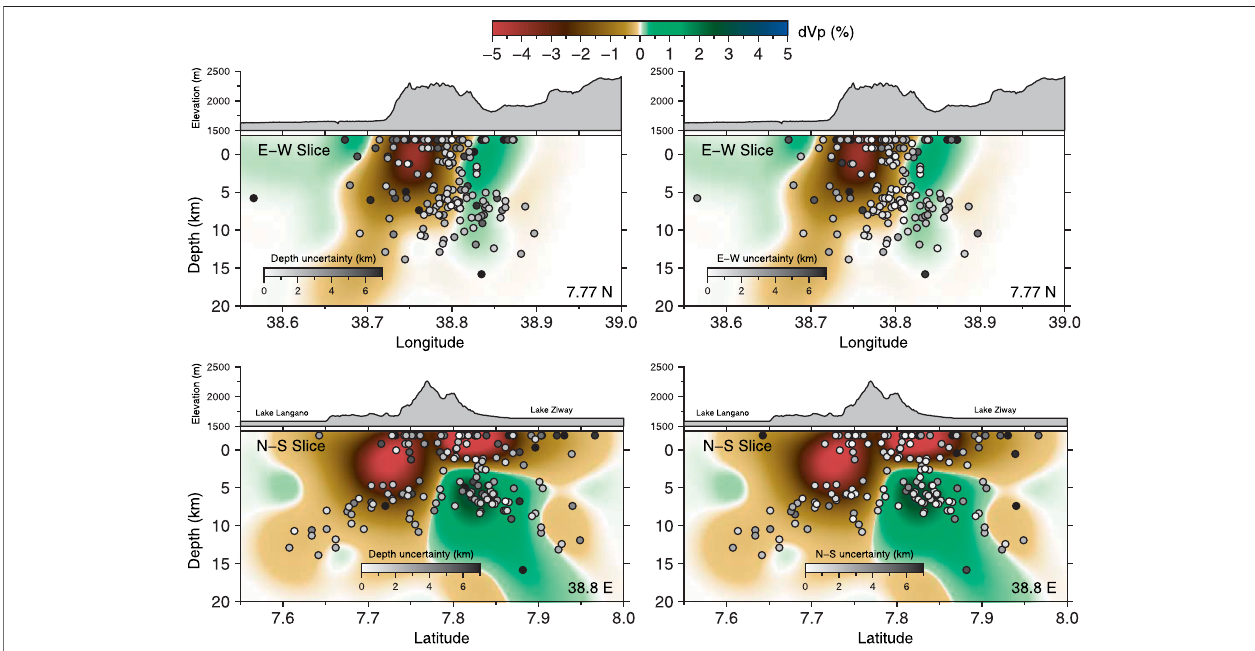
FIGURE 2 | Relocated earthquake uncertainties. East – west (upper) and north – south (lower) slices through the P-wave solution model with all earthquakes superimposed. Earthquakes are shaded using a grey-scale that indicates uncertainty in depth (left) and uncertainty in longitude/latitude (right) . The top pro fi les are along a latitude of 7.77 N and the bottom pro fi les are along a longitude of 38.8 E.